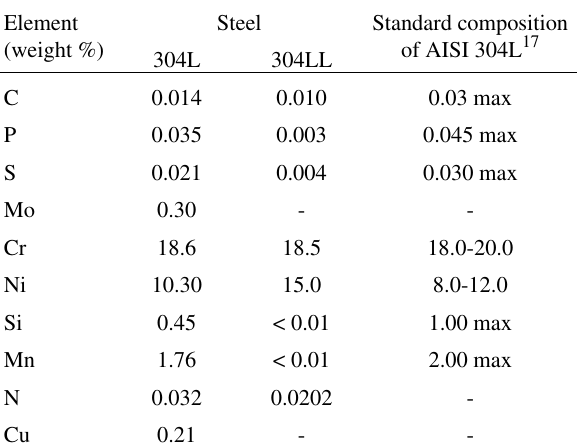
Table 1. Chemical composition of steels .